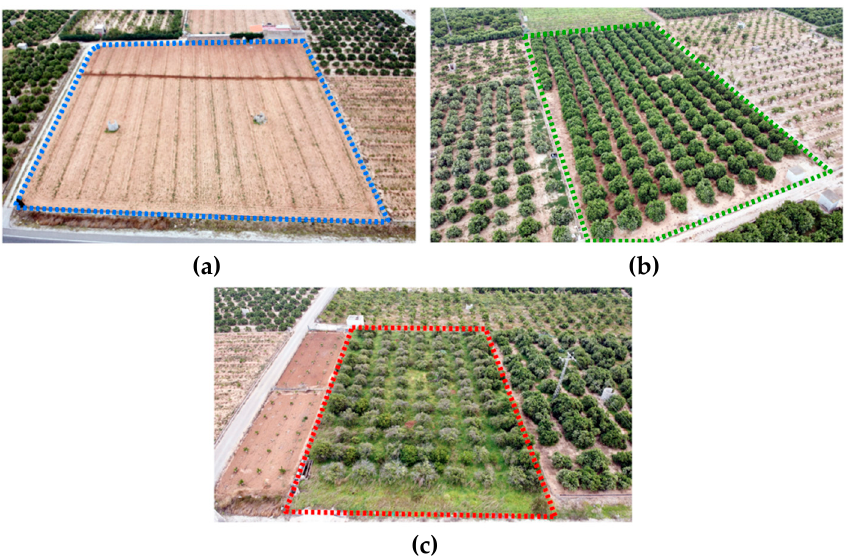
Figure 1. Location of the study area ( a ) in the Valencian Region ( b ), Spain ( c ).